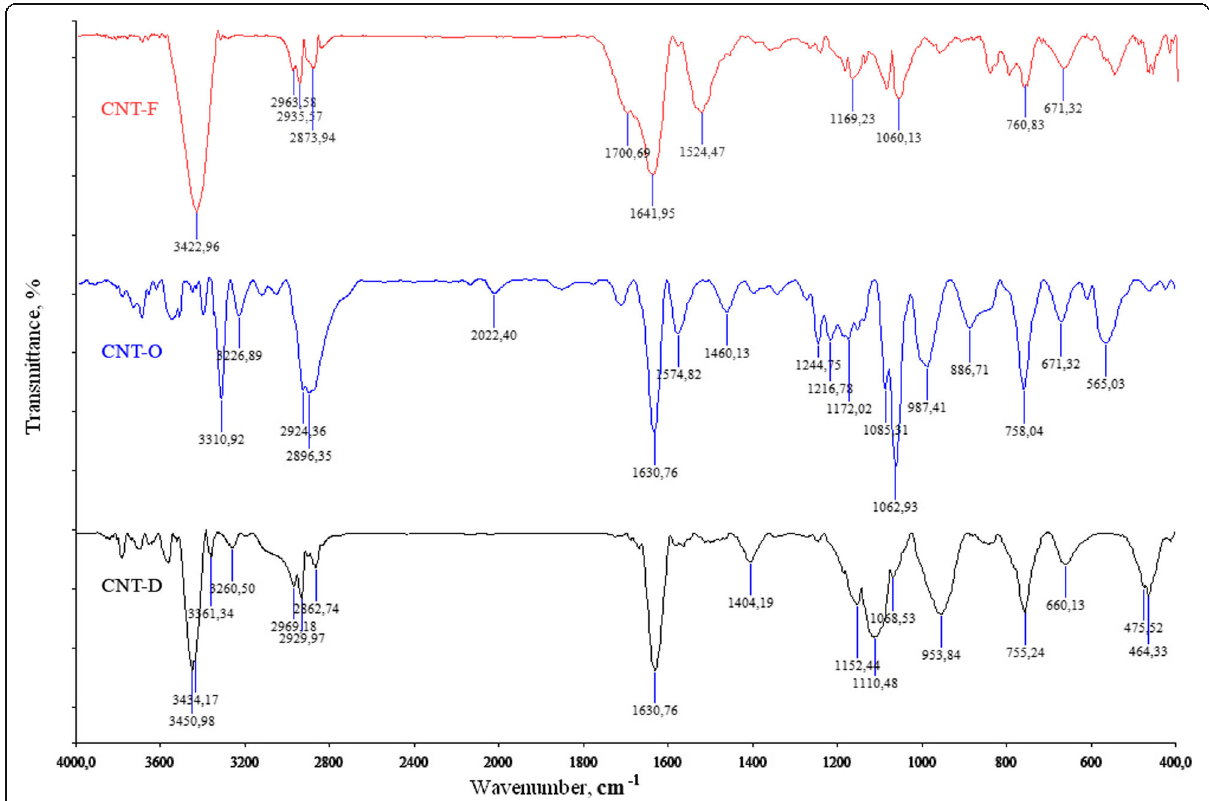
Fig. 4 Infra-red spectra of CNTox (CNT-O), CNT-DOX (CNT-D), CNT-FITC (CNT-F)